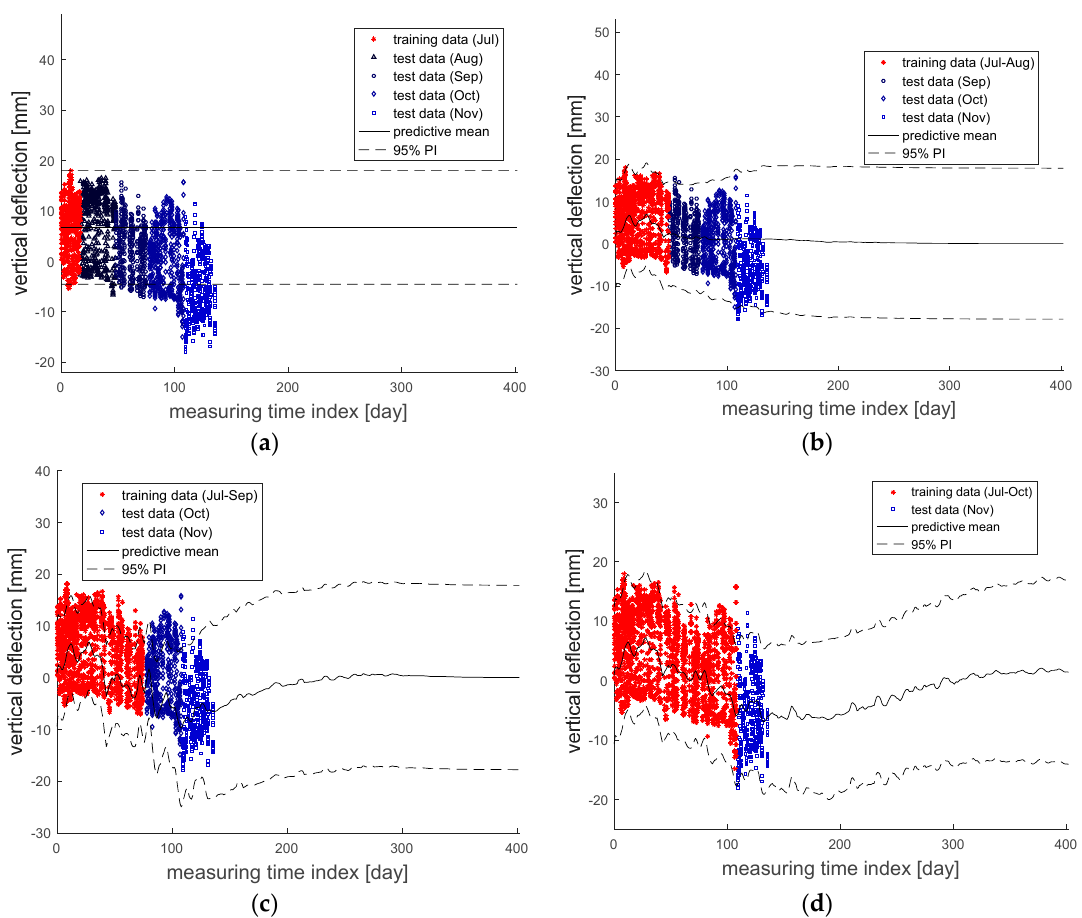
Figure 7. Comparison between the actual measurement data and the prediction results based on the datasets within: ( a ) July; ( b ) July to August; ( c ) July to September; ( d ) July to November.